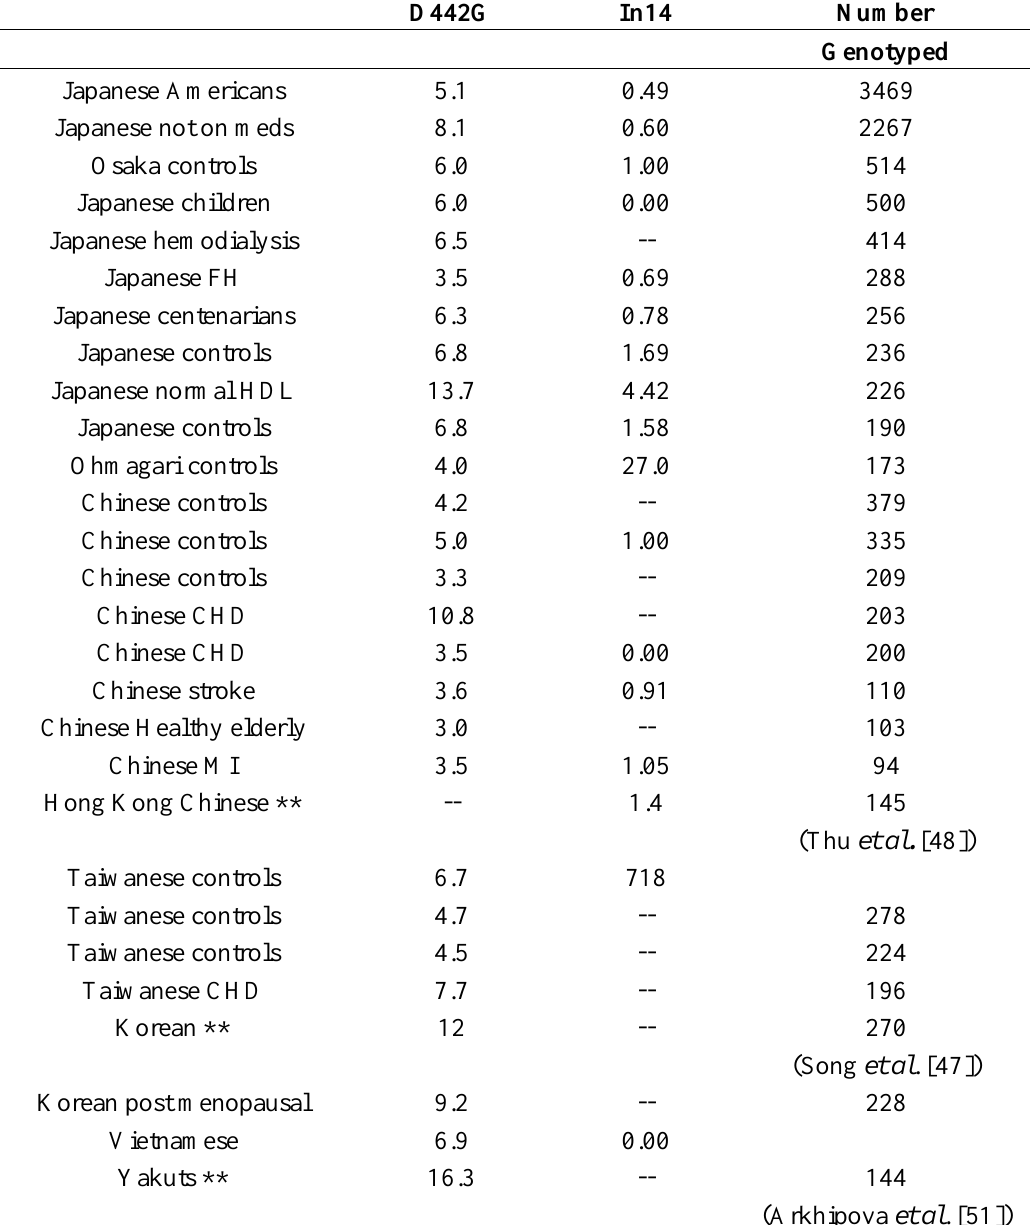
Table 4. Allele Frequency identified as prevalence of mutants, summarized by Thompson et al . * [50], unless otherwise referred to